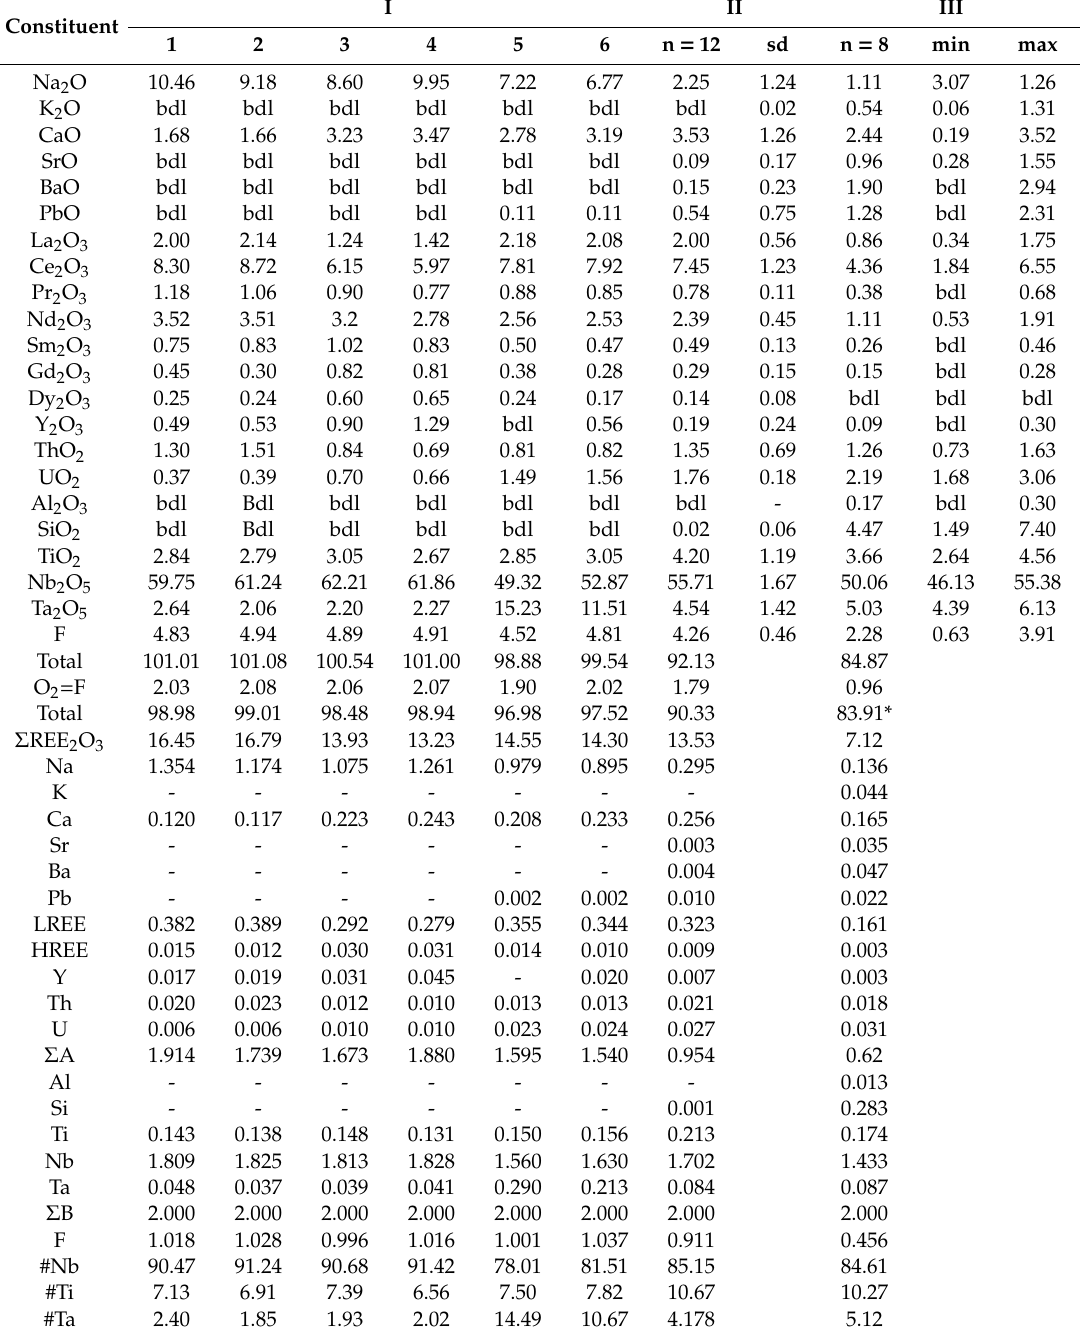
Table 1. Chemistry (wt.%) of pyrochlore-group minerals from the Katugin biotite-arfvedsonite granite (WDS